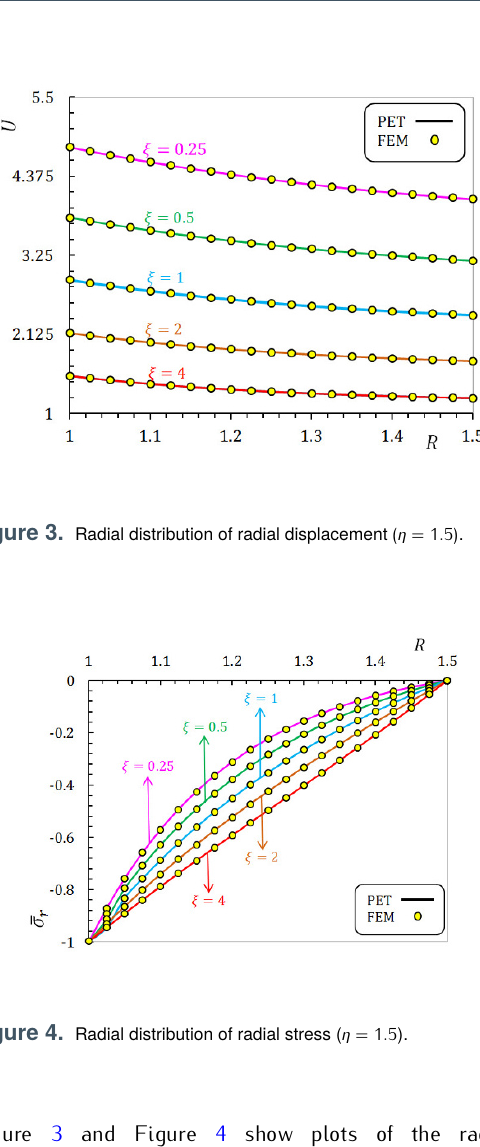
compared to those in a homogeneous disk ( ξ =